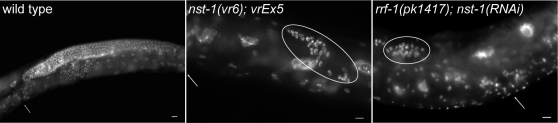

nst-1 is required in the germ line for germ cell development.Wild type, nst-1(vr6); vrEx5, and rrf-1(pk1417); nst-1(RNAi) progeny adults were stained for DAPI to visualize nuclei. Germ cells in one gonad arm of nst-1(vr6); vrEx5 and rrf-1(pk1417); nst-1(RNAi) animals are circled. Arrows indicate the vulva. Scale bars are 10 µm.